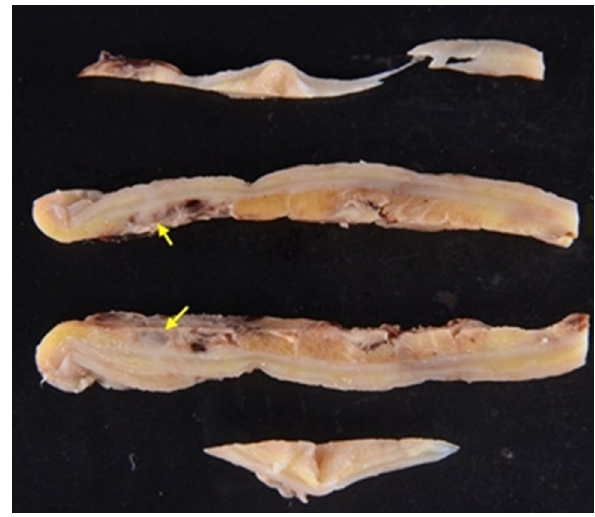
Fig. 2 The excised specimen. The appendix of the resected specimen has diverticula. Arrows: appendix